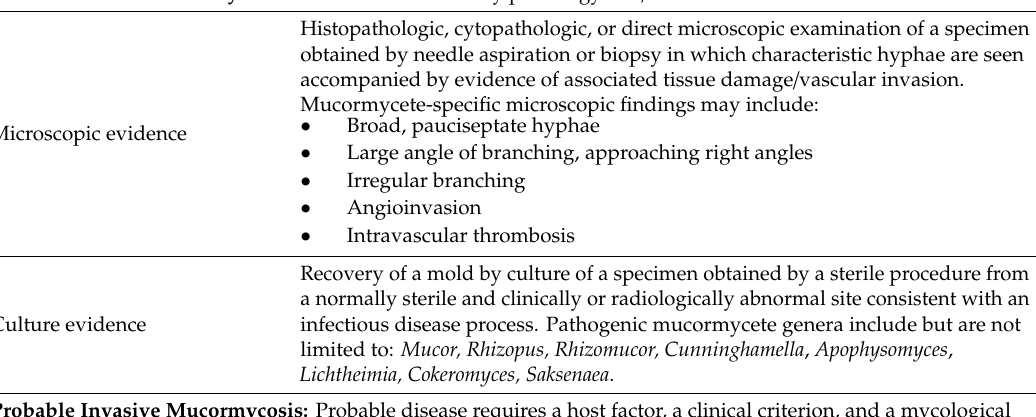
Table 1. Case definition for invasive mucormycosis, adapted from the European Organization for Research and Treatment of Cancer (EORTC) and National Institute of Allergy and Infectious Diseases Mycoses Study Group (MSG); De Pauw et al. (2008)